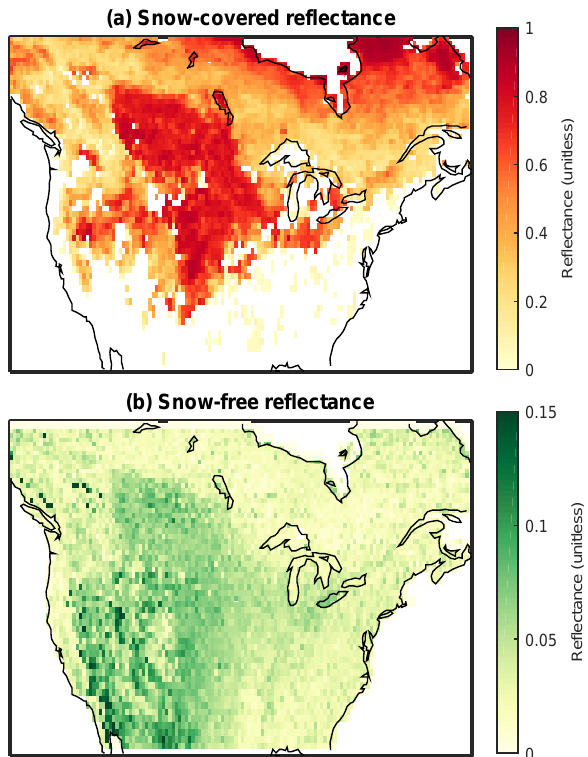
Figure 1. Surface reflectivity at UV–visible wavelengths for snow- covered and snow-free conditions for January 2013. White space in panel (a) indicates that no snow reflectance information is available.